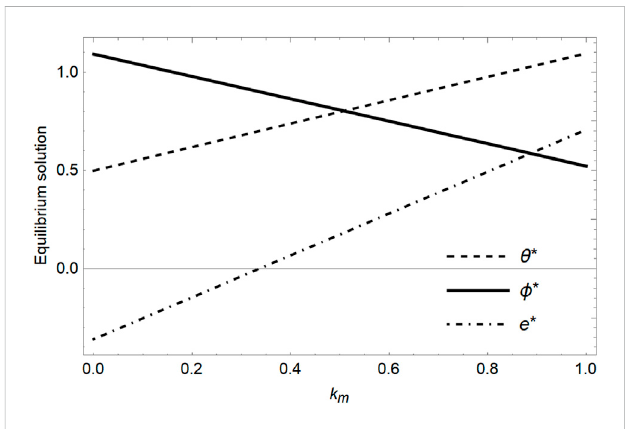
FIGURE 3 The impact of k m on equilibrium